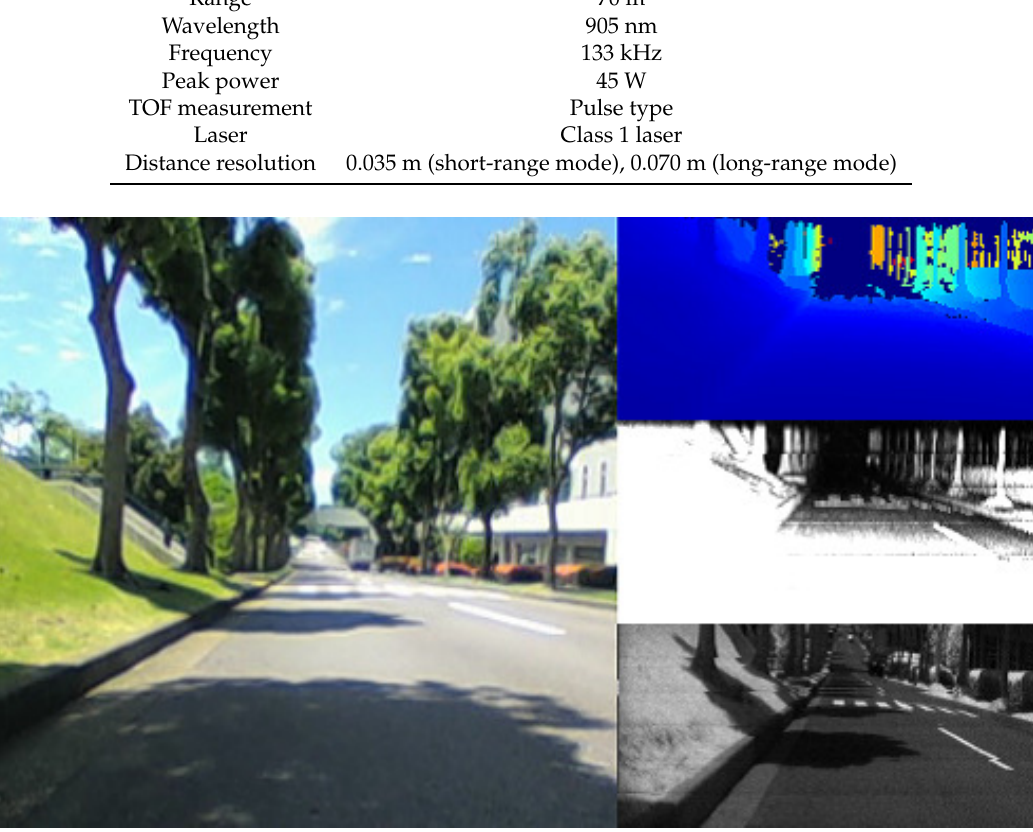
Figure 4. Example of outputs of the prototype LiDAR sensor with a reference image in an outdoor environment: ( top right ) range data; ( middle right ) peak intensity data; ( bottom right ) monocular data. Left figure shows reference image obtained by a camera.